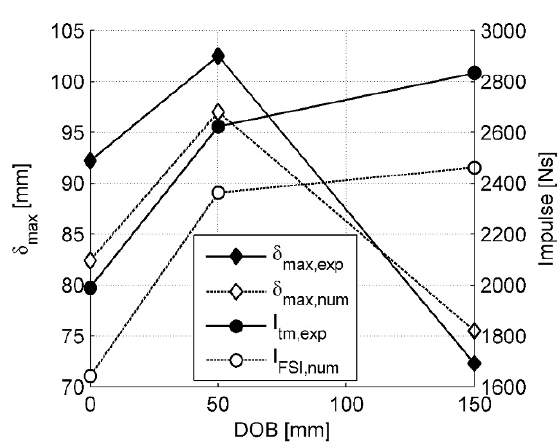
Figure 17. Force from the Fluid Structure Interaction (FSI) and max- imum displacement of the target plate, δ max , normalised to its maximum value for each burial depth (DOB) is illus- trated against time.